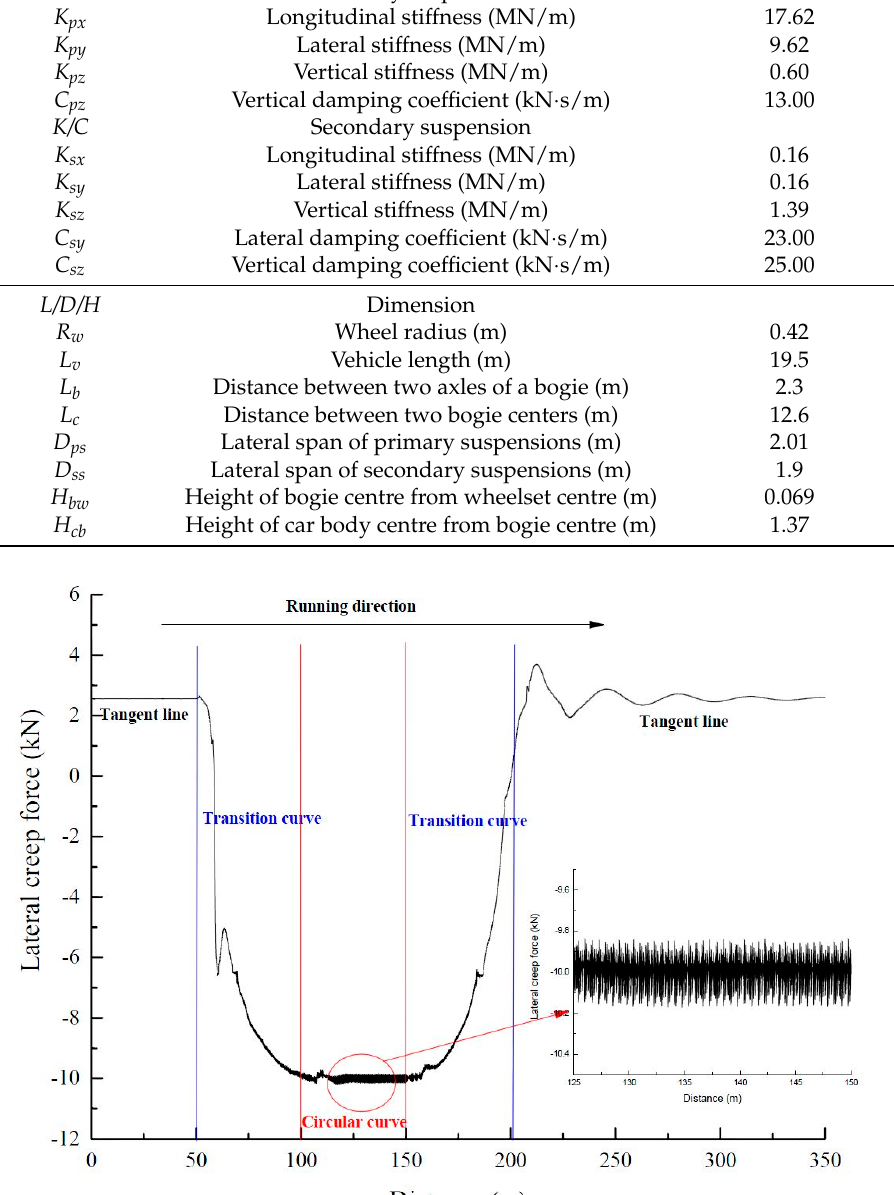
Figure 7. Lateral creep force of the leading wheelset when a vehicle negotiates a narrow curve (simulation results).